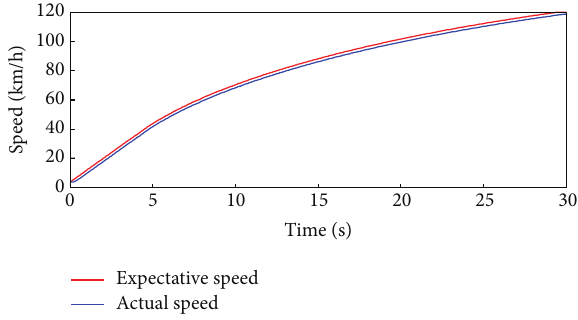
Figure 16: The acceleration driving cycle and actual following DC.